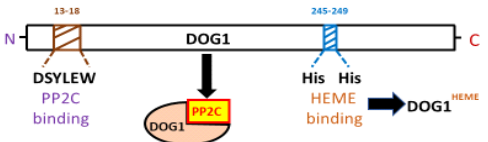
Figure 4. AtDOG1 protein structure indicating the positions of the AHG1 and heme binding sites. DOG1 is an α -helical protein that has the ability to bind both ABA HYPERSENSITIVE GERMINATION1 (AHG1; a clade A protein phosphatase 2C) and heme group. The amino acid residues that specifically bind PP2C (i.e., DSYLEW) are very close to the N-terminal; while those that specifically bind heme group are closer to the C-terminal. Heme binding is not necessary for DOG1 interaction with AHG1. However, heme binding at His245 and His249 is essential for DOG1 function in seed dormancy. Modified from Nonogaki (2019) [1,48]. Plants 2020 , 9 , x FOR PEER REVIEW